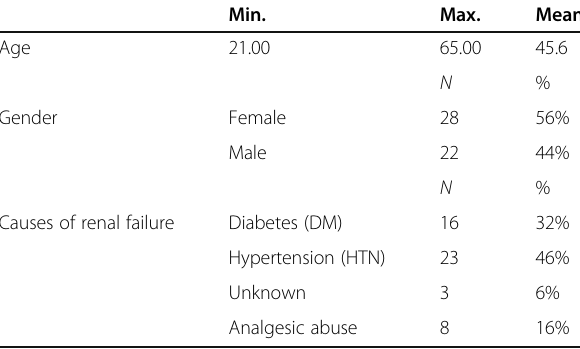
Table 1 Demographic data and original kidney disease for all study population ( N =50)